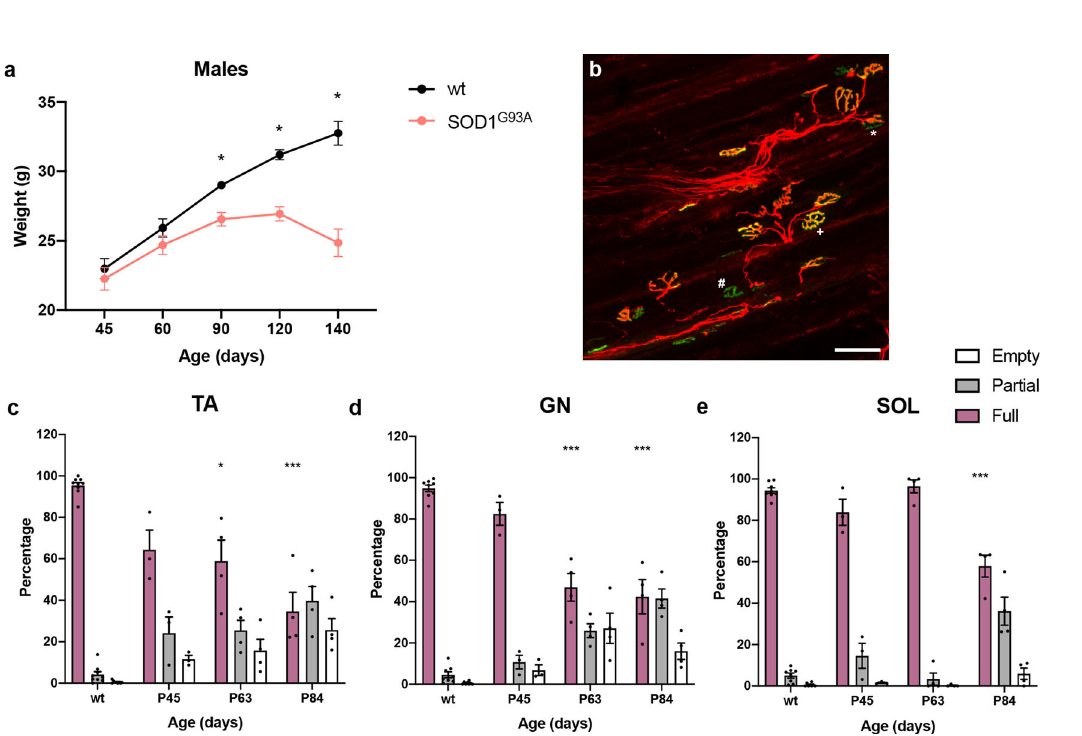
Fig. 2 Neuromuscular junction (NMJ) innervation assessment in the fast-twitch fatigable Tibialis Anterior (TA) (c) and Gastrocnemius (GN) (d) muscles and in the slow-twitch Soleus (SOL) (e) muscle. a Weights of the SOD1 G93A mice included in the study and used for comparison with the multiple crossing conditions. Differences in weights are observed from postnatal day 90 (two-tailed multiple t tests, P90 P = 0.00008, t = 4.773, df = 24; P120 P = 0.0000003, t = 7.125, df = 23; P140 P = 0.0012, t = 5.713, df = 6; N = 15 independent mice per condition). NMJ were categorized either as fully innervated, shown by + in ( b ), or as partially innervated, shown as * in ( b ), or as empty, shown as # in ( b ). Signi fi cant denervation in TA ( c ) (one-way ANOVA and Dunnett ’ s post hoc, F (3, 12) = 9.767, P63 P = 0.0200, P84 P = 0.0005) and GN ( d ) was in P63 mice (one-way ANOVA and Dunnett ’ s post hoc, F (3, 12) = 19.36, P63 P = 0.0003, P84 P = 0.0001). e In SOL, signi fi cant denervation was much later starting from P84 (one-way ANOVA and Dunnett ’ s post hoc, F (3, 12) = 20.82, P84 P = 0.00005) (wt N = 8, SOD1 G93A P45 N = 3, P63 N = 4, P84 N = 4 independent mice). Scale bar in ( b ) = 50 μ m. A minimum of 800 NMJs were analyzed per condition. In all graphs, data are presented as mean values ± SEM. Source data are provided as a Source Data fi